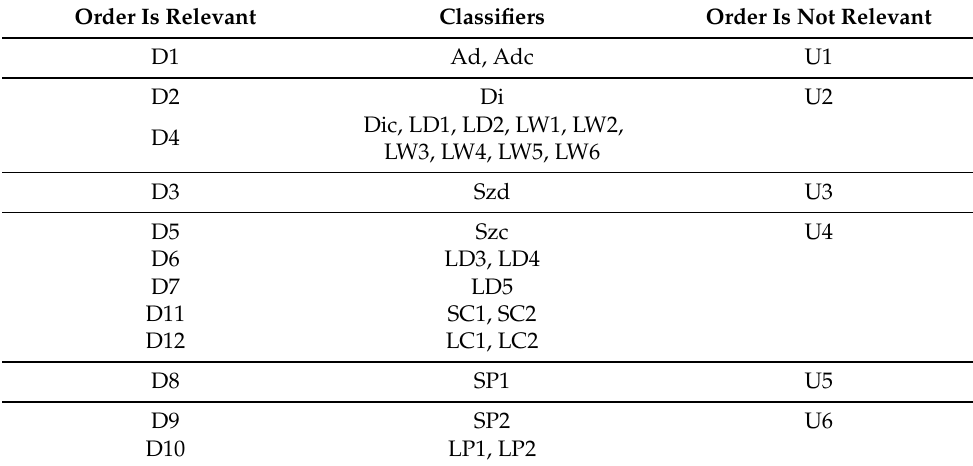
Table 11. Different partitions of vertices for C 28 − D 2 .